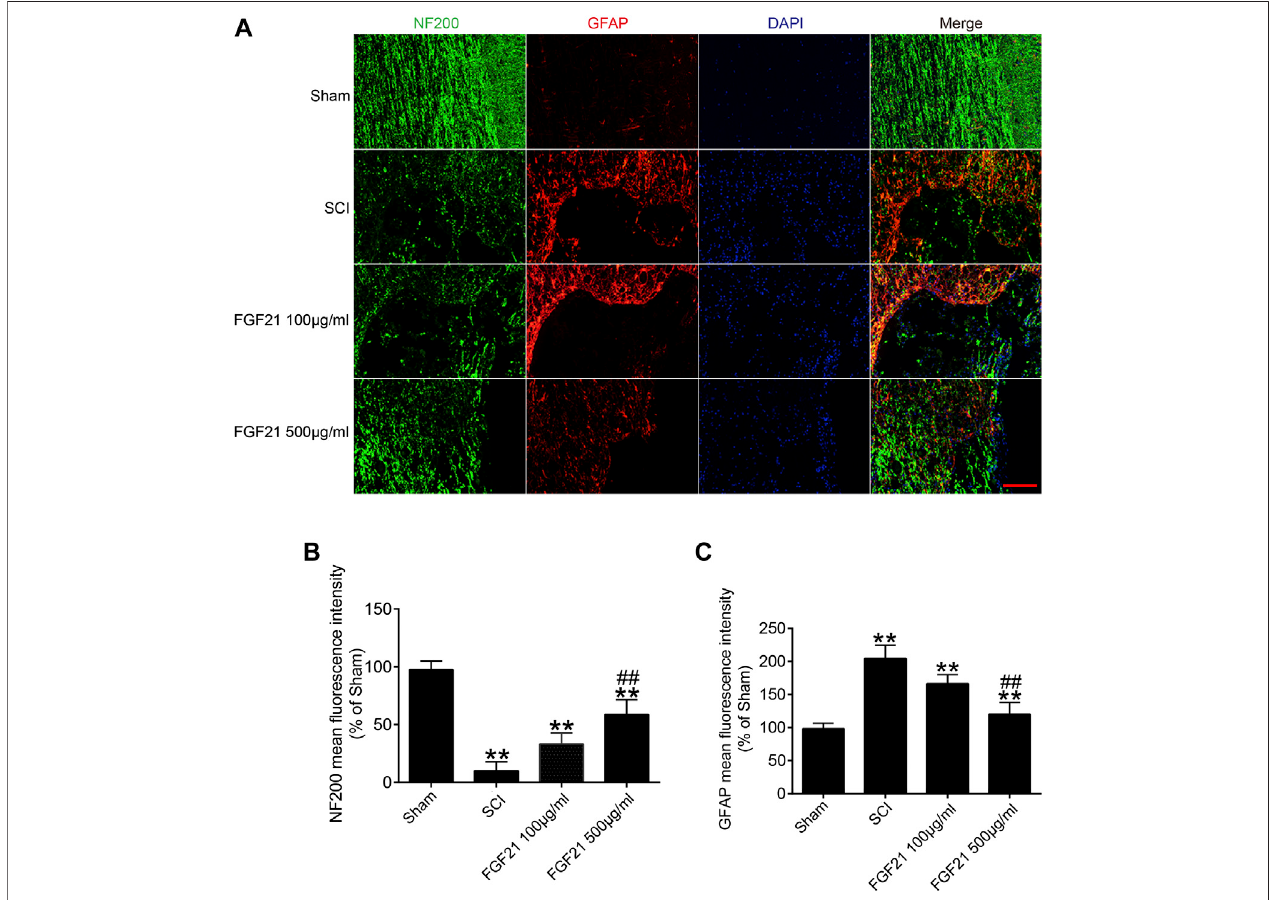
FIGURE5| FGF21treatmentincreasestheexpressionofNF200,anddeceasestheexpressionofGFAP (A) NF200andGFAPstaininginthesham,SCIgroup,and FGF21 treated groups. The positive bright green dots represent NF200 staining, while the bright red dots represent GFAP staining. DAPI (blue) is in application to mark nuclei, Scale bar (cid:1) 100 μ m (B,C) Quanti fi cation of the NF200 and GFAP positive staining is re fl ected by mean fl uorescence intensity. Representation of data is mean values ± SEM, n (cid:1) 6, “ ** ” represent p < 0.01 vs the SCI or Sham group, “ ## ” represent p < 0.01 vs the 100 μ g/ml FGF21 group.